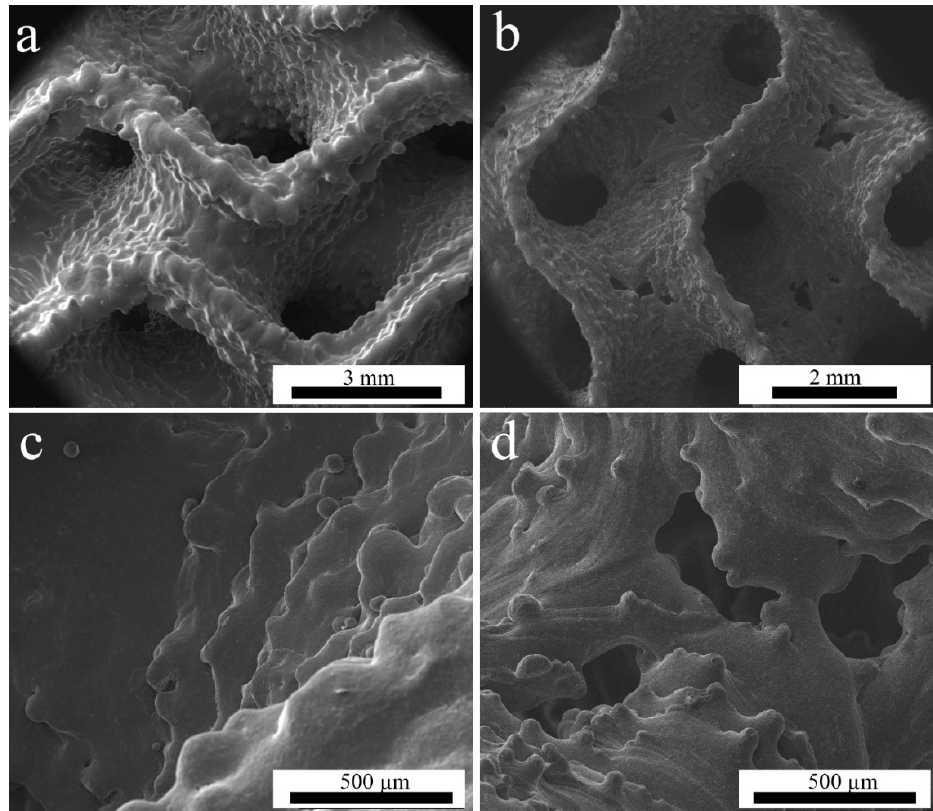
Figure 2. SEM images of ( a , c )—MT specimen; ( b , d )—WT specimen.